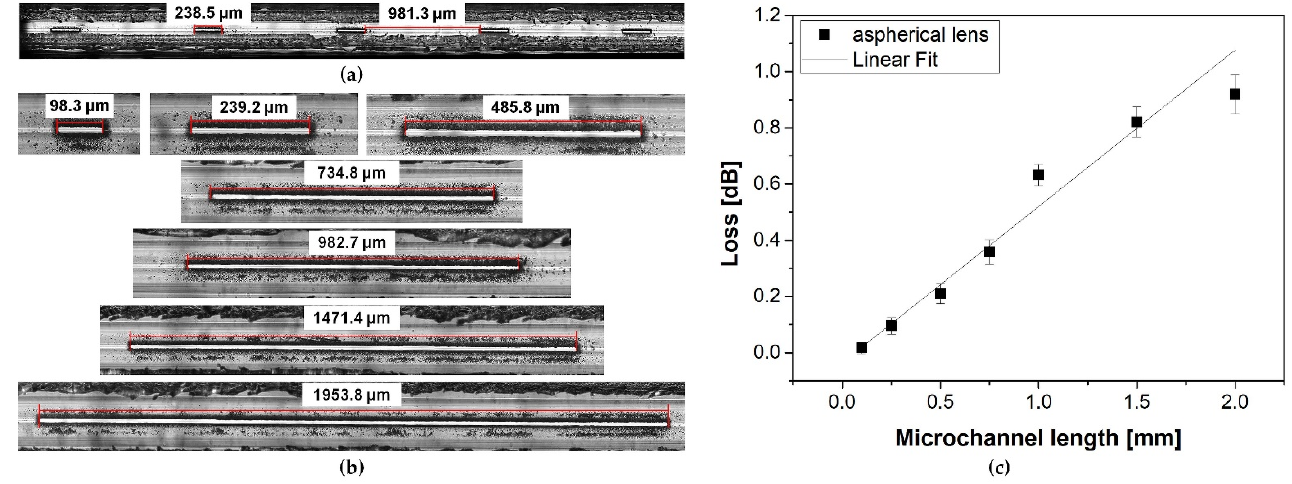
Figure 9. Additional loss of the ARHFC plotted as a function of the length of the microchannel: ( a ) view of a single section containing 5 microchannels with a length of 0.25 mm, ( b ) microchannels with lengths equal to 0.1, 0.25, 0.5, 0.75, 1, 1.5, 2 mm, respectively, and ( c ) loss vs. microchannel length.